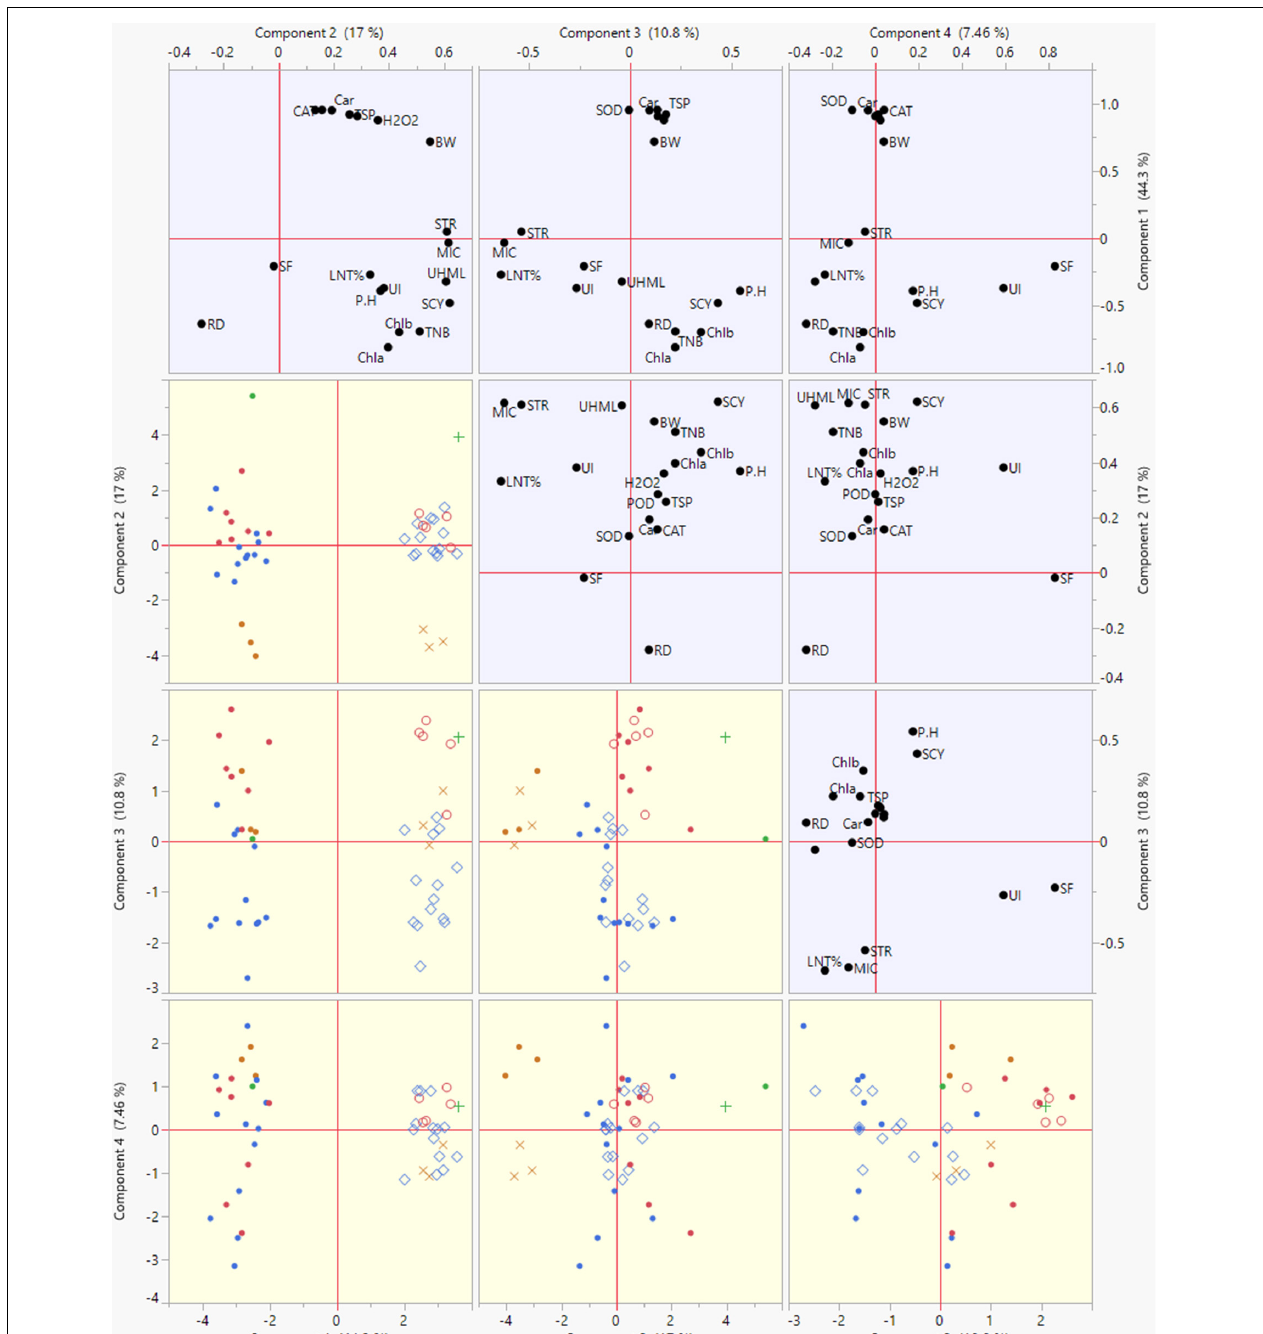
FIGURE 5 | Scatterplot of PC1, PC2, PC3, and PC4 displaying their contribution to the total variability of genotypes based on studied agronomic, biochemical, and fiber-related traits under normal and high temperature stress